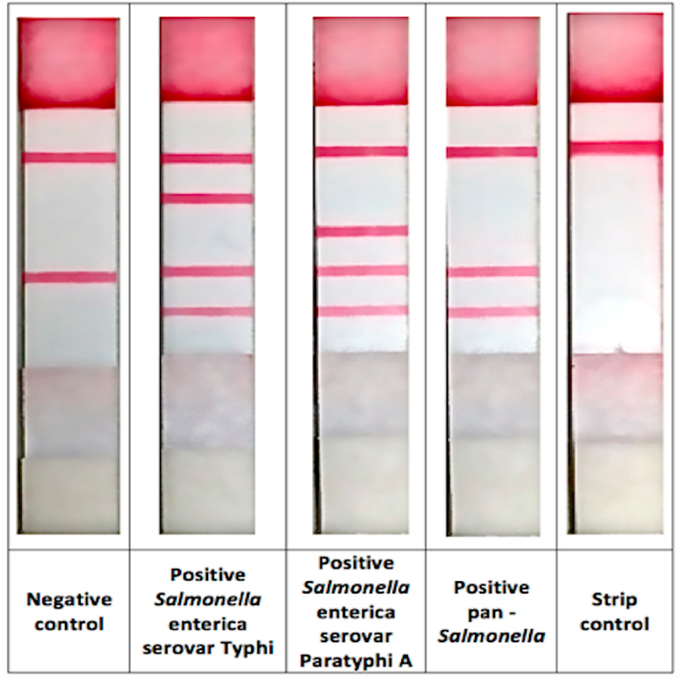
Figure 4. The representative of the mPCR-LFB in line-format.